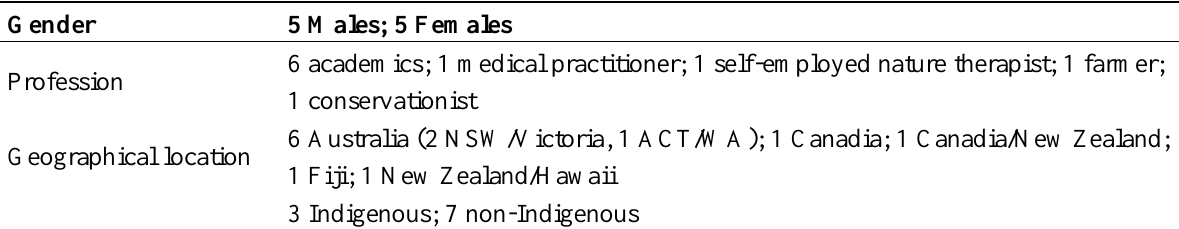
Table 1. Participants’